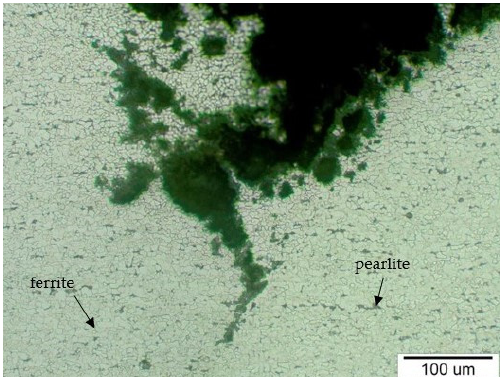
Figure 10. Sampling points T2, T3 with observed areas (indicated by arrows). On sample T1, the observed area was parallel with the outer surface of the tube.